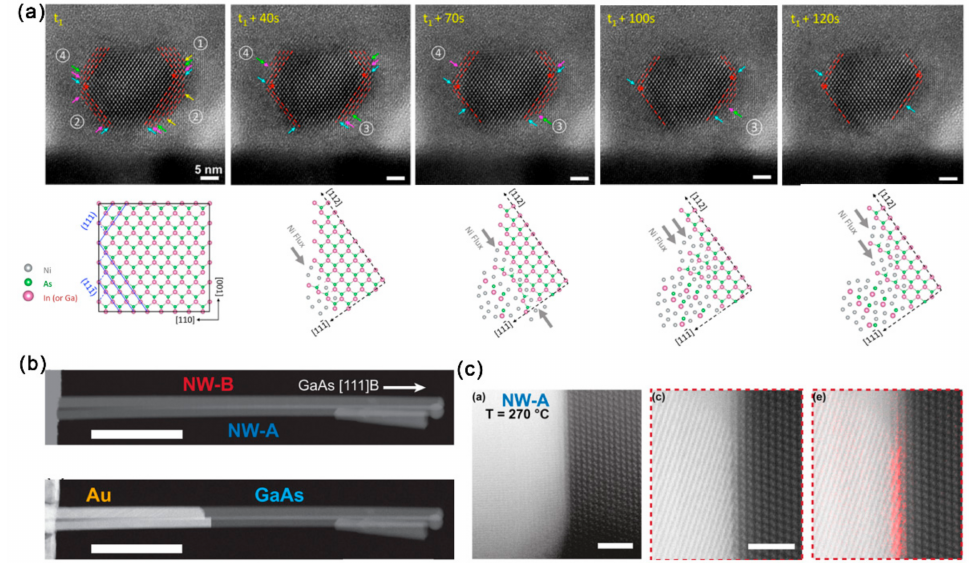
Figure 9. ( a ) The ledge formation and movement mechanisms at atomic resolution and the proposed (cid:0) (cid:1) (cid:2) (cid:3) mechanism of ledge movement on the 111 plane along [112] or 112 directions. Reproduced with permission [92]. Copyright 2017, American Chemical Society. ( b ) HAADF-STEM images presenting the GaAs NWs before (upper) and after (bottom) partial heat-induced replacement by Au. ( c ) HAADF- HRSTEM images showing the interface of Au–GaAs at elevated temperatures. Reproduced with permission [12]. Copyright 2016, American Chemical